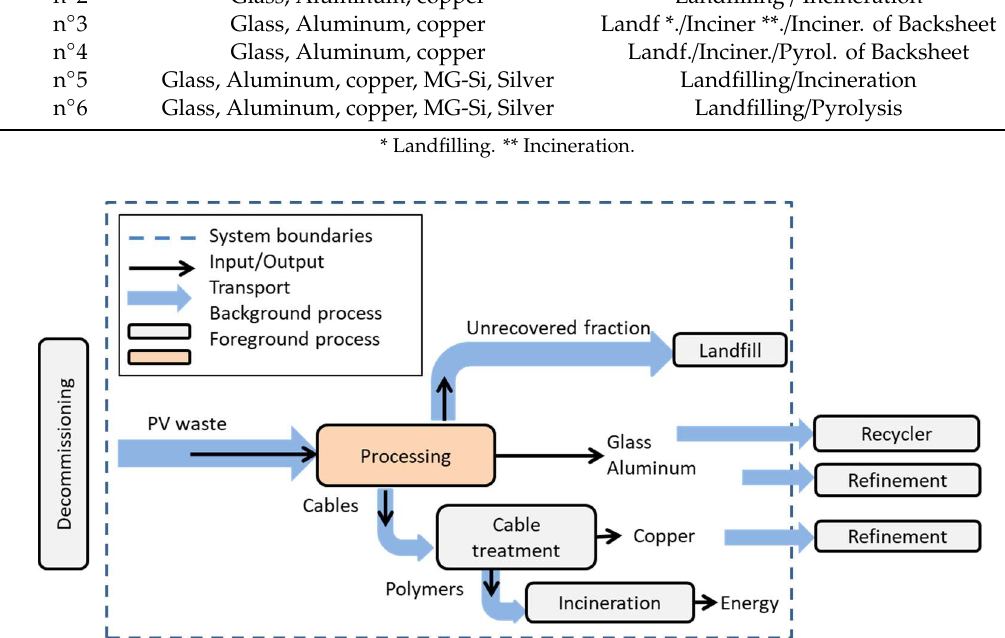
Figure 2. Exemplary process flow chart of a recycling approach (appr. n°1).